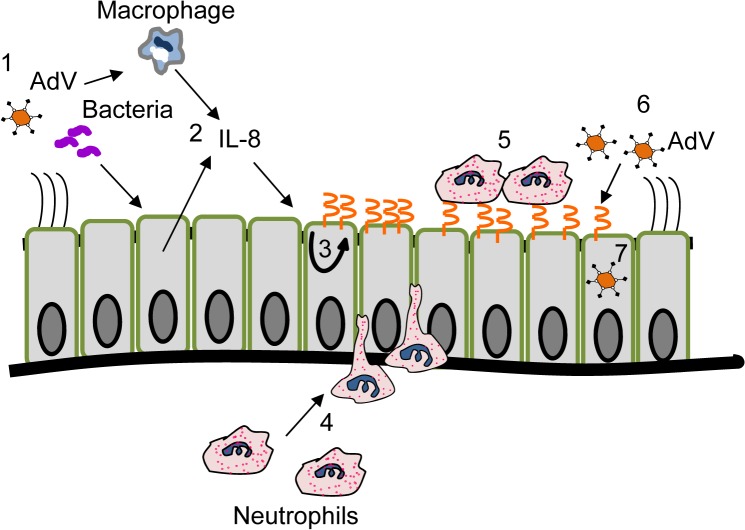
Schematic of IL-8-mediated enhancement of AdV entry into polarized epithelia.1) Pathogenic microbes that invade the airway 2) cause both the resident macrophages and the epithelial cells to secrete IL-8. 3) IL-8 exposure causes intracellular signaling within the epithelial cells that augments de novo protein synthesis and apical localization of CAREx8. 4) IL-8 simultaneously recruits neutrophils that transmigrate through the epithelium from the basal surface to the apical surface and 5) bind to CAREx8 at the apical surface of the epithelium. 6) AdV entering the airway hijacks the host innate immune response and apical CAREx8 to gain entry into the host cell.